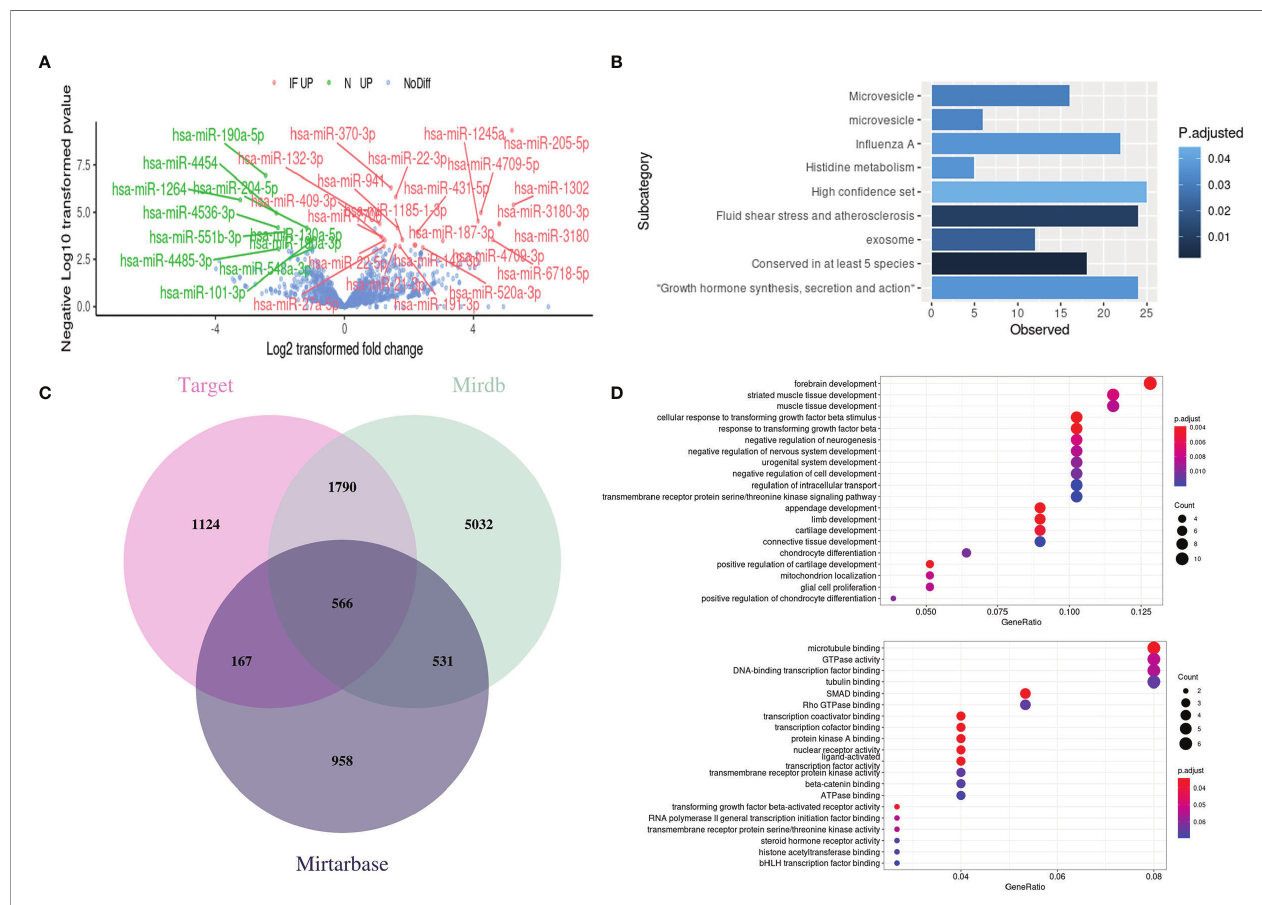
FIGURE 5 | Identi fi cation of differentially expressed miRNAs (DEMs) and functional enrichment analysis of their target genes. (A) Volcano plot of DEMs between CE and the controls with the signi fi cant ones labeled and highlighted (IF UP, upregulated in in fl amed CE; NC UP, upregulated in controls; NoDiff, no signi fi cant difference). (B) The enrichment plot of DEMs showed the top enriched miRNA clusters through miEAA online tools. (C) Venn diagram of targeted genes from the different miRNA-target prediction databases. (D) The top enriched GO terms in Biology Progress (top) and Molecular Function (bottom) for the putative target genes. The Vertical axis presents the GO categories, the horizontal axis represented the gene ratio which was de fi ned as the number of the putative target genes associated with particular term divided by the total number of the putative target genes. P <